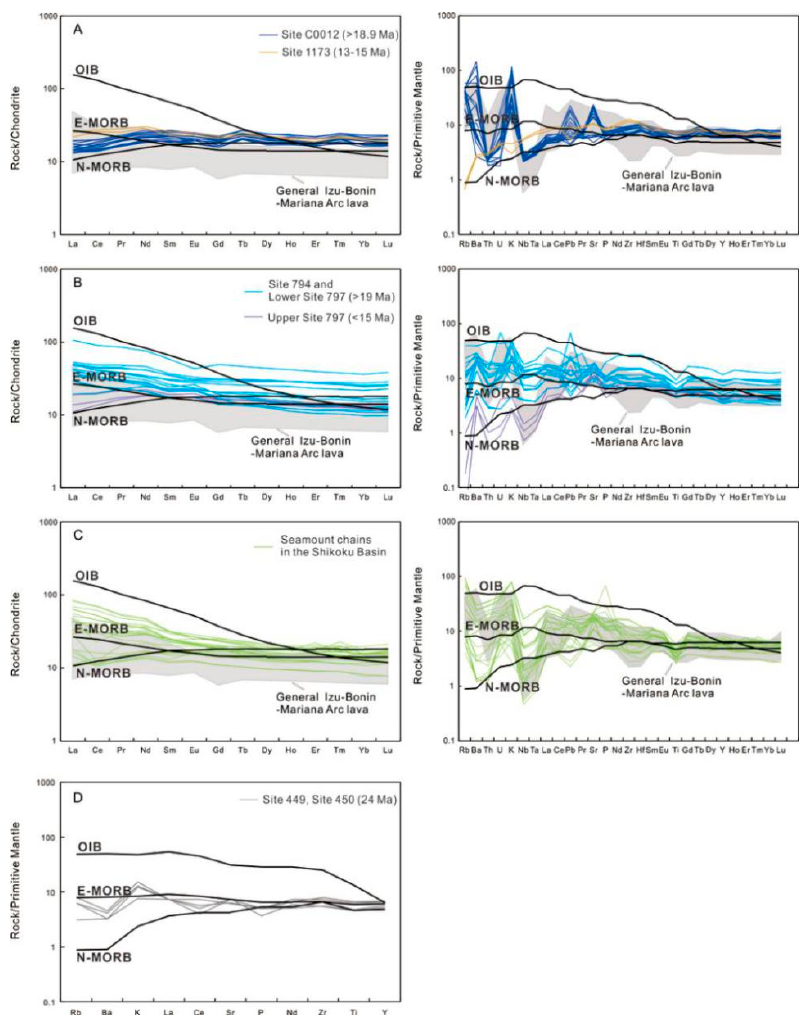
Figure 9. Chondrite normalized rare earth elements (REE) patterns and primitive mantle normalized multi-element patterns for the Site C0012 and 1173 volcanic rocks from the Shikoku Basin ( A ), the Site 797 and 794 volcanic rocks from the Japan Sea ( B ), the seamount chains from the Shikoku Basin ( C ), and the Site 449 and 450 volcanic rocks from the Parece Vela Basin ( D ). The data of general Izu-Bonin-Mariana (IBM) arc lava are from Reference [57]. Data sources as for Figure 6.